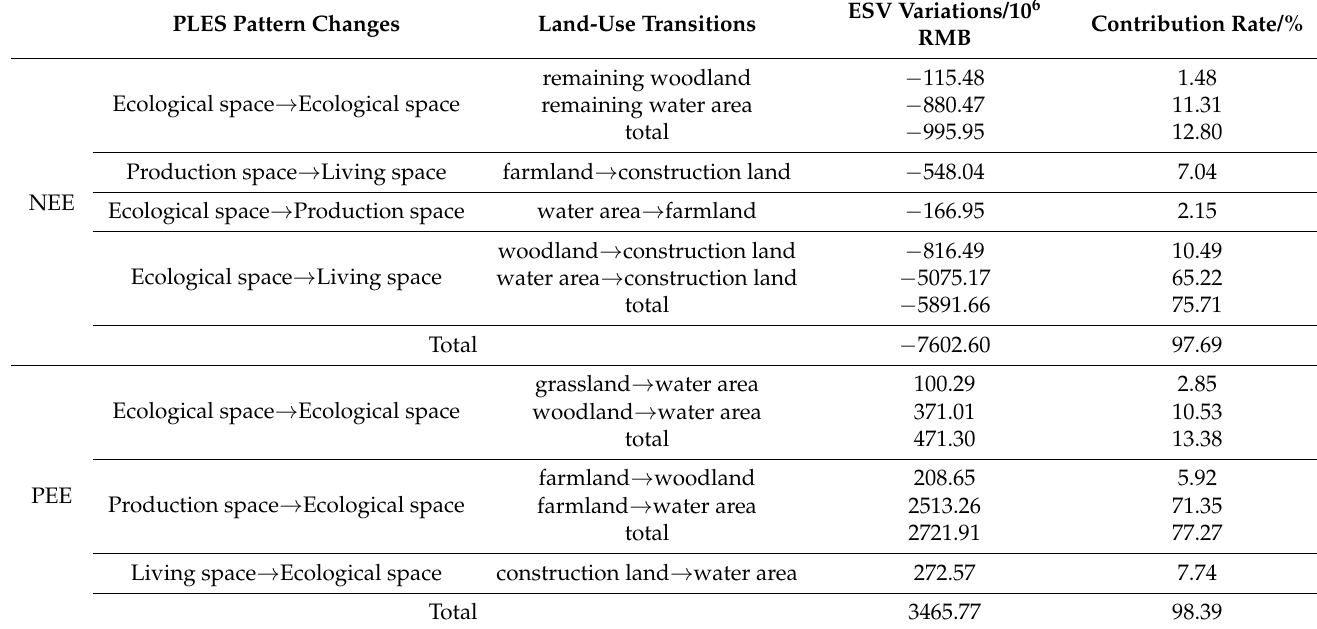
Table 10. PLES pattern changes affecting ESV in the NERAs during 2005–2018. A contribution rate < 1 was not under consideration. PLES Pattern